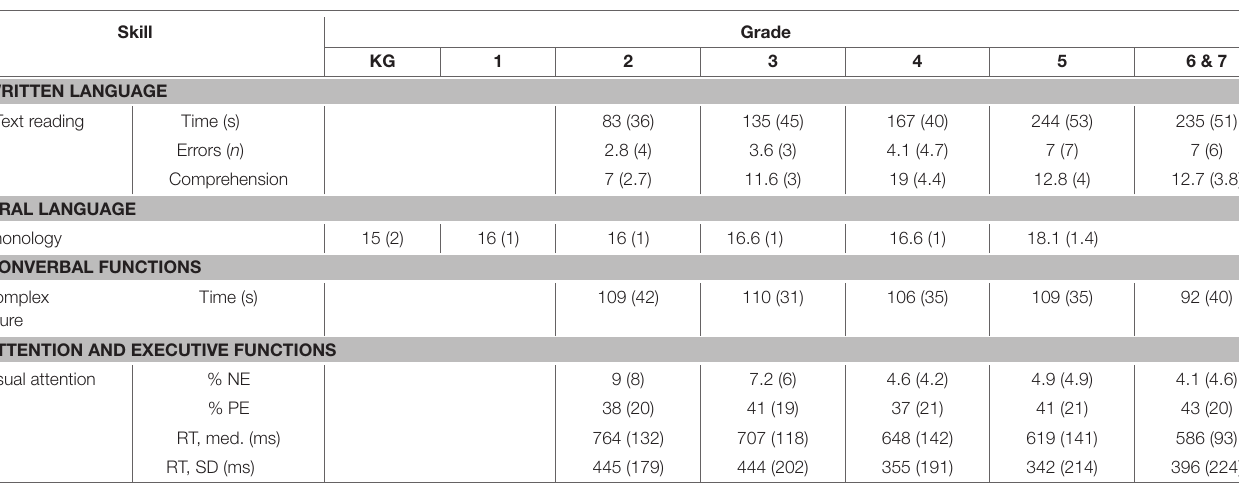
TABLE 6 | Reliability of tests for which Cronbach’s alpha not calculable.